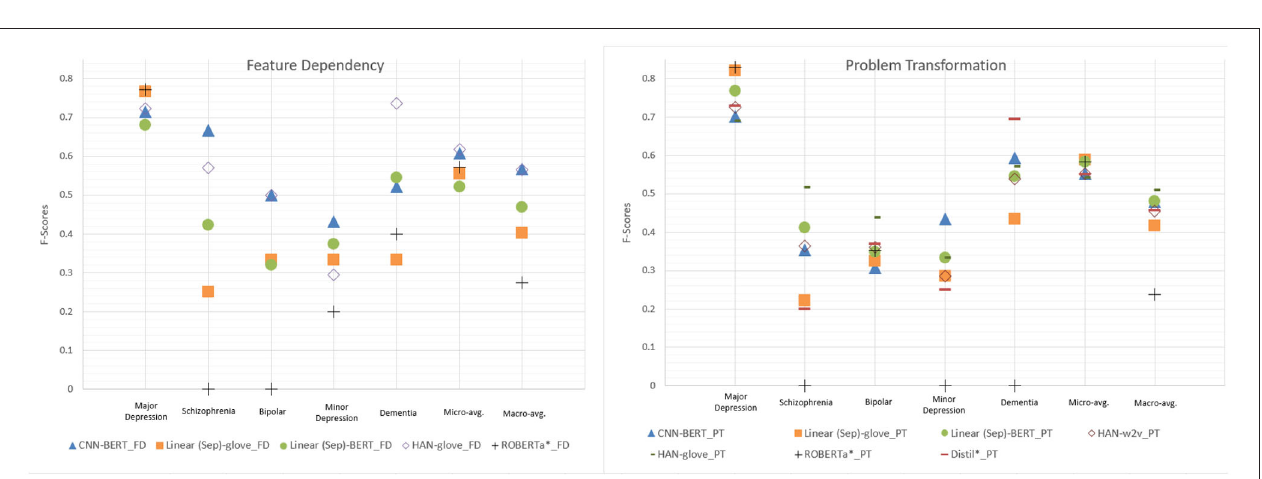
FIGURE 5 | Performance comparison of the top performing models selected from the developed network architectures. PT and FD denote problem transformation and feature dependency, respectively. The fine tuning approaches (ROBERTa*_PT/FD and Distill*_PT) with the best micro- and macro-avg. F-scores are also included for